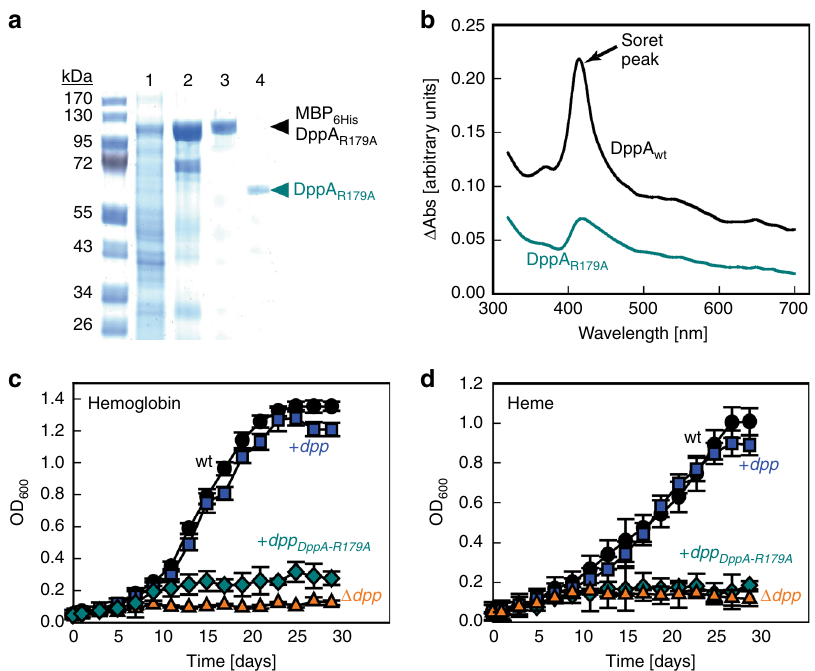
Fig. 6 Arginine 179 of DppA is essential for heme binding and utilization by M. tuberculosis . a Puri fi cation of DppA R179A from E. coli . Lanes: (1) E. coli lysate containing mbp 6his -dppA R179A expression vector, combined fractions after Ni(II)-af fi nity (2) and amylose af fi nity (3), (4) puri fi ed DppA R179A post TEV cleavage after Ni(II) recapture of MBP 6His . b Difference absorption spectroscopy of DppA wt and DppA R179A . The free heme spectra were subtracted from the heme-incubated protein spectra at protein concentrations of 10 µ M. Growth of avirulent Mtb mc 2 6206 (circles), the Δ dpp mutant ML2436 (triangles), ML2436 complemented with wt dpp operon genes (squares) and ML2436 complemented with dpp operon genes but expressing dppA R179A (diamonds). Strains were grown in HdB minimal medium with 2.5 µ M human hemoglobin ( c ) or 10 µ M hemin ( d ). Medium with hemin and hemoglobin contained 20 µ M of 2,2 ′ -dipyridyl to prevent utilization of trace ferric iron. Error bars represent standard errors of mean values of biological triplicates. Please note that the data in Fig. 5c, d for wt (circles), ML2436 (triangles), and ML2436 complemented with wt dpp operon genes (squares) are the same as in Fig. 1b. Growth experiments for all strains were performed at the same time. Source data are provided in the Source Data fi